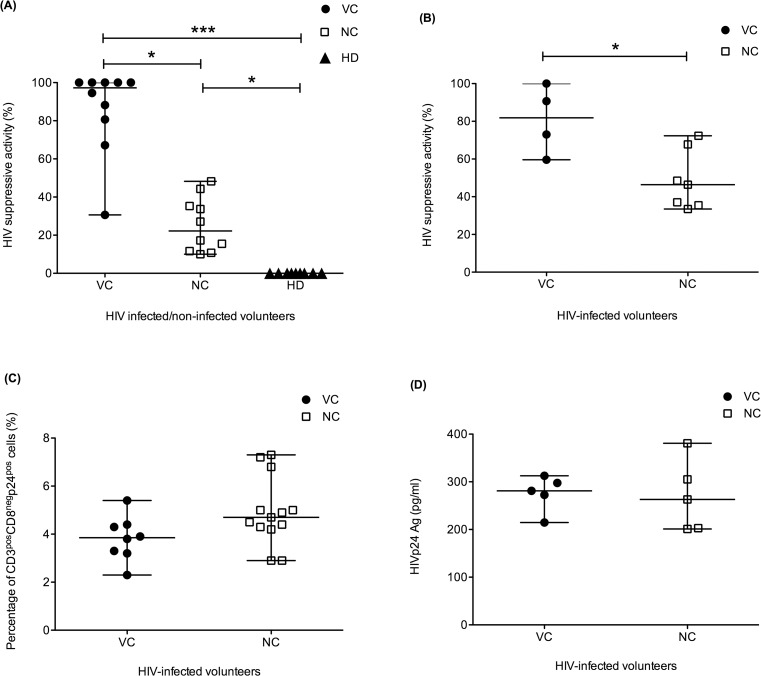

In vitro HIV suppression assay.
(A)
In vitro HIV suppression assay mediated by ex vivo unstimulated CD8+ T cells in VC (N = 10, filled circle), NC (N = 10, open rectangle), and healthy volunteers (HD, N = 9, filled triangle) cocultured with autologous HIV-infected CD4+ T cells at E:T ratio of 1:1 at day 7. (B)
In vitro HIV suppression assay mediated by HIVp24-specific T cell lines from VC (N = 4, filled circle) and NC (N = 7, open rectangle) cocultured with autologous HIV-infected CD4+ T cells at E:T ratio of 1:1 at day 3. (C) Percentages of ex vivo HIV-infected CD4+ T cells (CD3posCD8negP24pos) in VC (N = 8, filled circle) and NC (N = 13, open rectangle) (D) Production of newly-generated HIV from CD4+ T cells from VC (N = 5, filled circle) and NC (N = 5, open rectangle) at day 7. The Y-axis depicts the concentration of HIVp24 Ag (pg/ml) from ELISA assays. *p value <0.05 and ***p value<0.001.